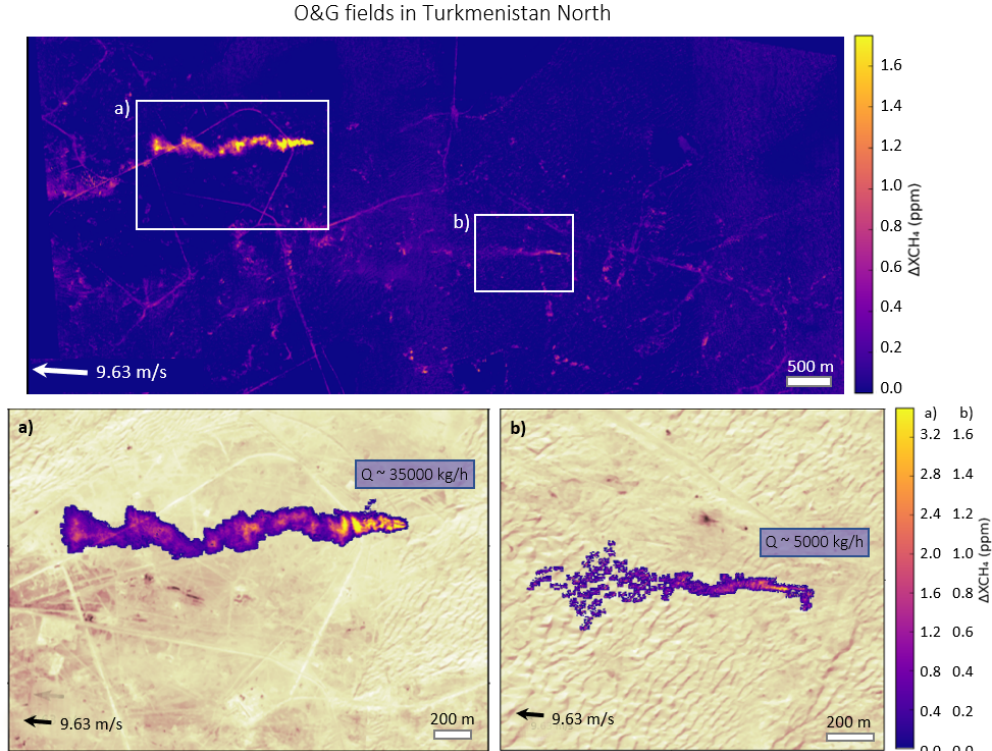
Figure 12. (cid:49) XCH 4 map produced from the real image of Turkmenistan North (Eastern image); Goturdepe field on 10 April 2021, where two emissions are detected. Zoom panels show the plumes over band 1 of the © WV-3 SWIR image used as a background. The plumes in (a) and (b) come from two different pipelines located, respectively, at coordinates 39.474 ◦ N, 53.743 ◦ E; and 39.462 ◦ N, 53.775 ◦